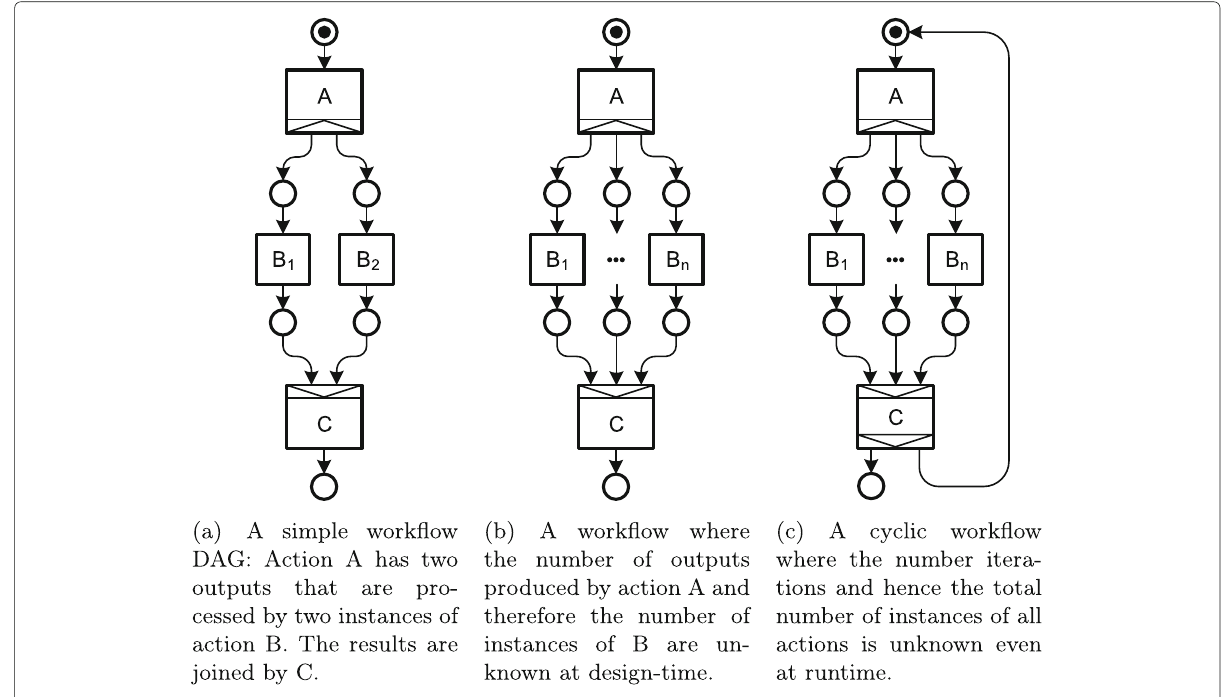
Fig. 1 Examples of workflow graphs. Petri Net notation according to van der Aalst & van Hee [14] (see also “Workflow model”